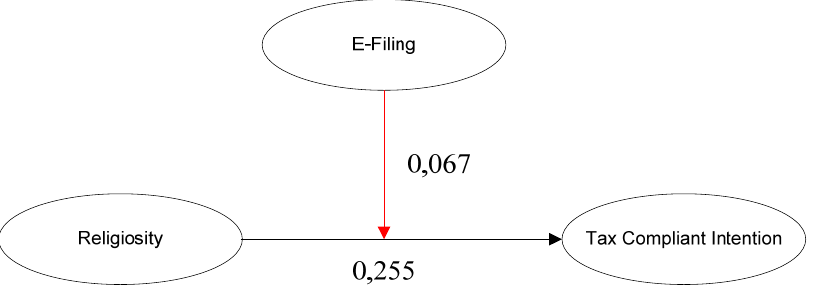
Figure 2. Moderation Effect of e ‐ Filing on the Relationship between Religiosity on Tax Compliant Intention. Source: Research Data (2020).